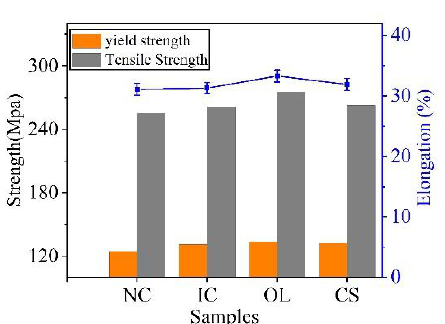
Figure 17. Yield strength (Mpa), tensile strength (Mpa), and elongation (%) of as-deposited specimens by different cooling processes.